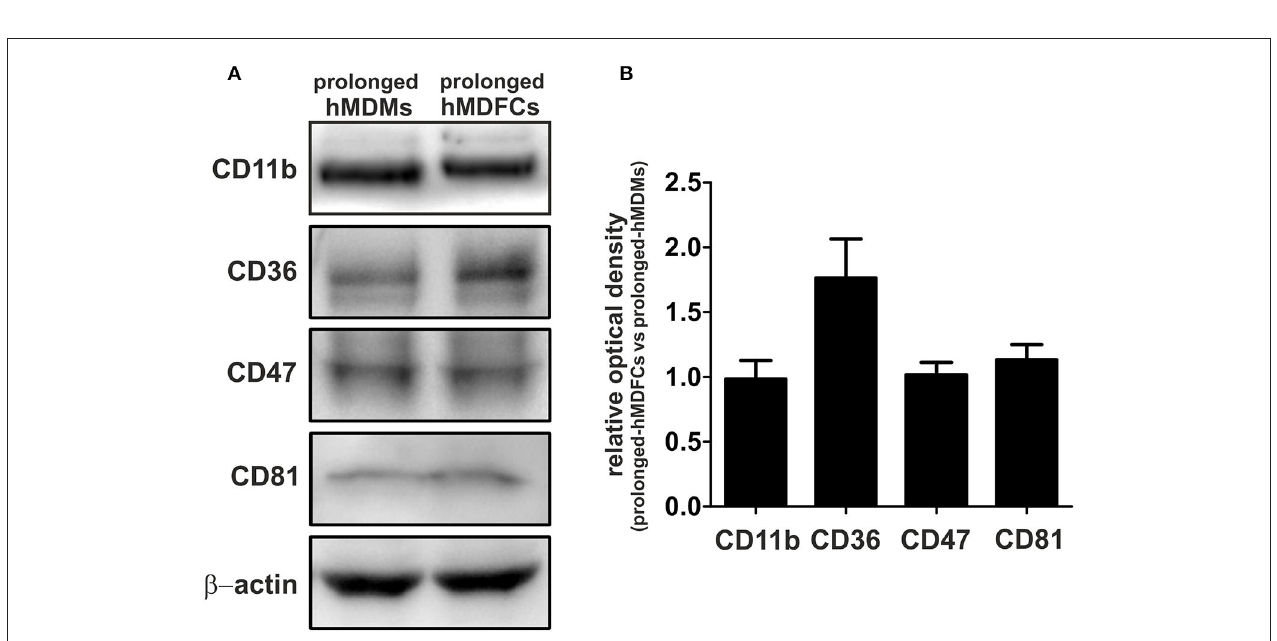
FIGURE 2 | Representative staining images are shown. (B,C) Flow cytometric analysis of surface receptors expression in prolonged-hMDMs and hMDFCs. The cells were stained with monoclonal antibodies or appropriate isotype controls. Data are displayed in the form of histogram overlays using % Max option, which scales each population curve to mode 100%. A representative example out of three donors is shown. Positive population was identified using Overtone subtraction technique (D,E) and relative level of receptor expression was determined by MFI values of positive population (F) . Results for prolonged-hMDFCs are expressed as a ratio to corresponding prolonged-hMDMs (100% indicated with dashed horizontal line). Raw data of receptors expression (% of positive cells and MFI) on prolonged-hMDMs and hMDFCs are presented in Supplementary Tables 1, 2 . Values are the means ± SD from at least three independent experiments (each in triplicate, n ≥ 9). * p < 0.05 vs. hMDMs.